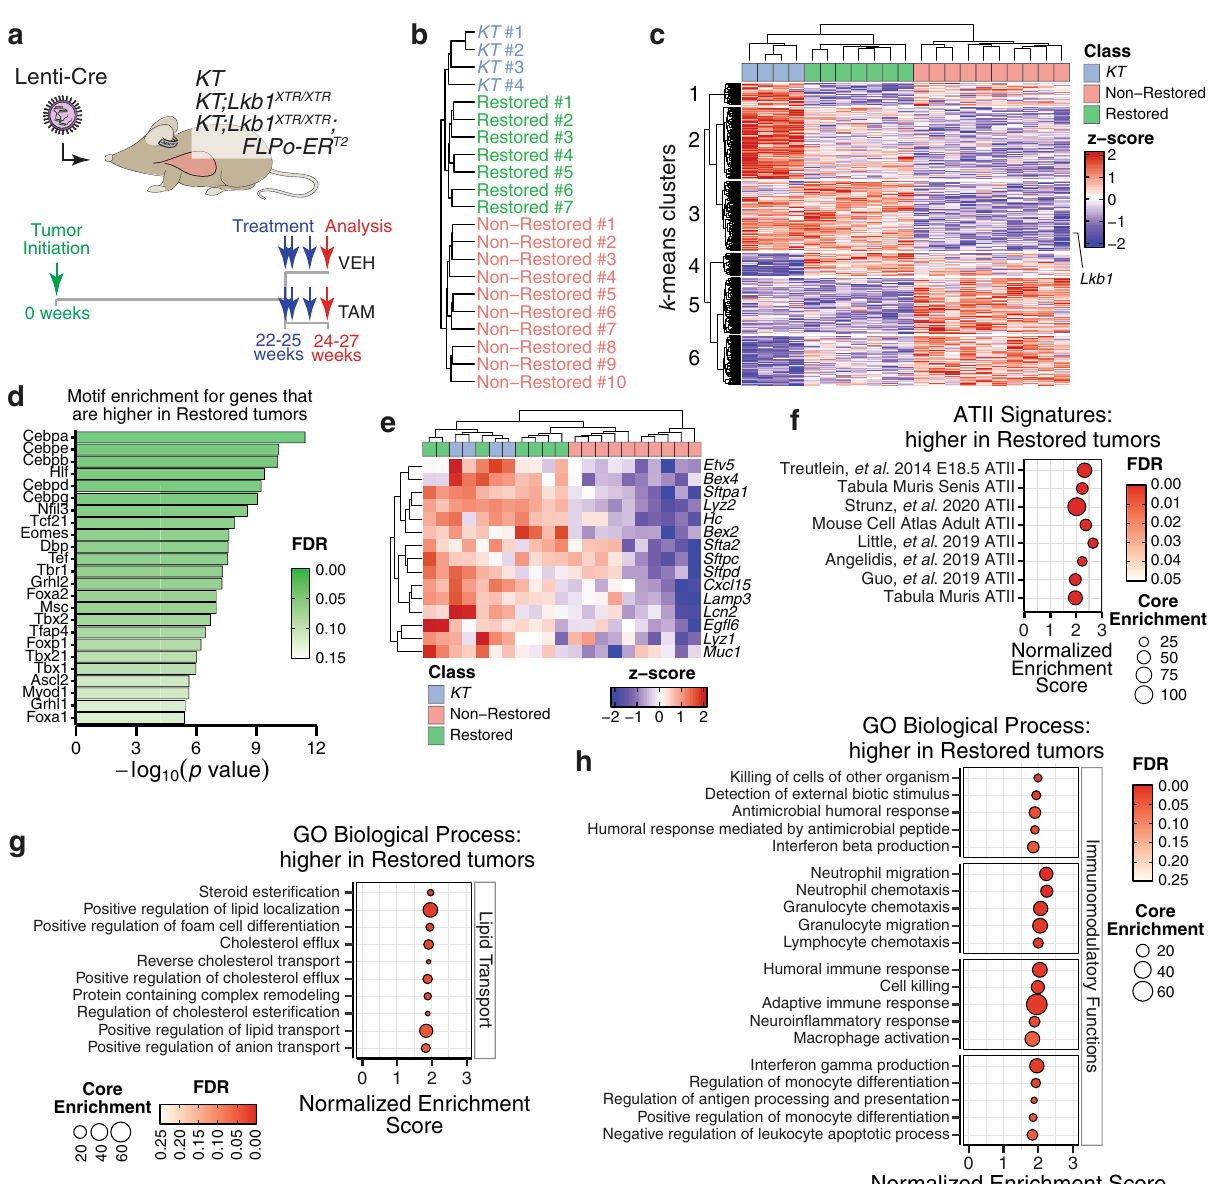
Fig. 3 Lkb1 restoration drives programs related to alveolar type II epithelial cell functions in lung adenocarcinoma. a Pro fi ling the acute transcriptional response to Lkb1 restoration within established lung tumors. Mice were treated with vehicle or tamoxifen for 2 weeks prior to fl uorescence-activated cell sorting (FACS)-isolation of tdTomato positive neoplastic cells for RNA-seq analysis. KT , n = 4 mice; KT;Lkb1 XTR/XTR -tamoxifen, n = 3 mice; KT;Lkb1 XTR/ XTR